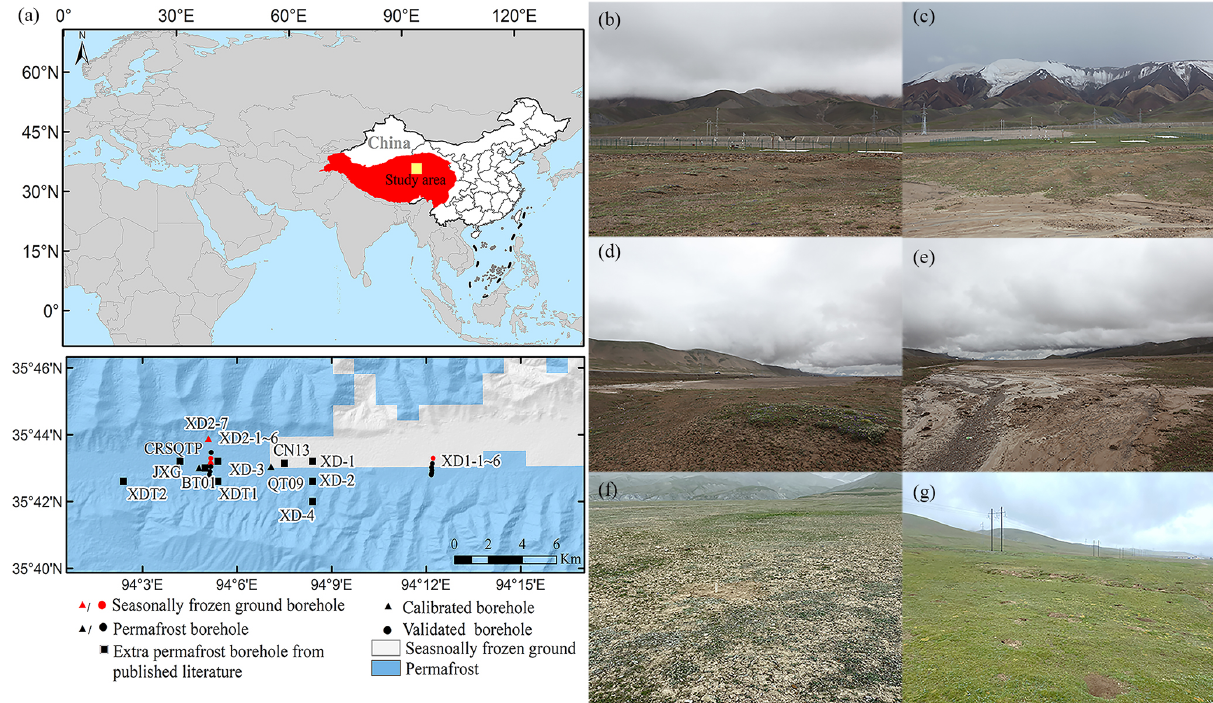
Figure 1. The geographical location of Xidatan on the QTP, its topography, and the location of 24 borehole sites (a) . Surface conditions at monitoring borehole sites (b–g) : view over the Xidatan COS (b) ; QT09, view towards the south (c) ; QT09, view towards the northeast (d) ; view from the vicinity of QT09 towards the east (e) ; XD2-1–XD2-7, view towards the south (f) ; XD1-1–XD1-6, view towards the east (g) (the spatial distribution of frozen ground types is derived from Zou et al., 2017; topography was generated by the digital elevation model (DEM) constructed from the Shuttle Radar Topography Mission (SRTM) with a 1arcsec resolution ( ∼ 30m); Jarvis et al., 2008; the Tibet Plateau boundary was taken from the National Tibetan Plateau Data Center; Zhang, 2019). All photographs were taken during the field investigation from 23 July to 2 August